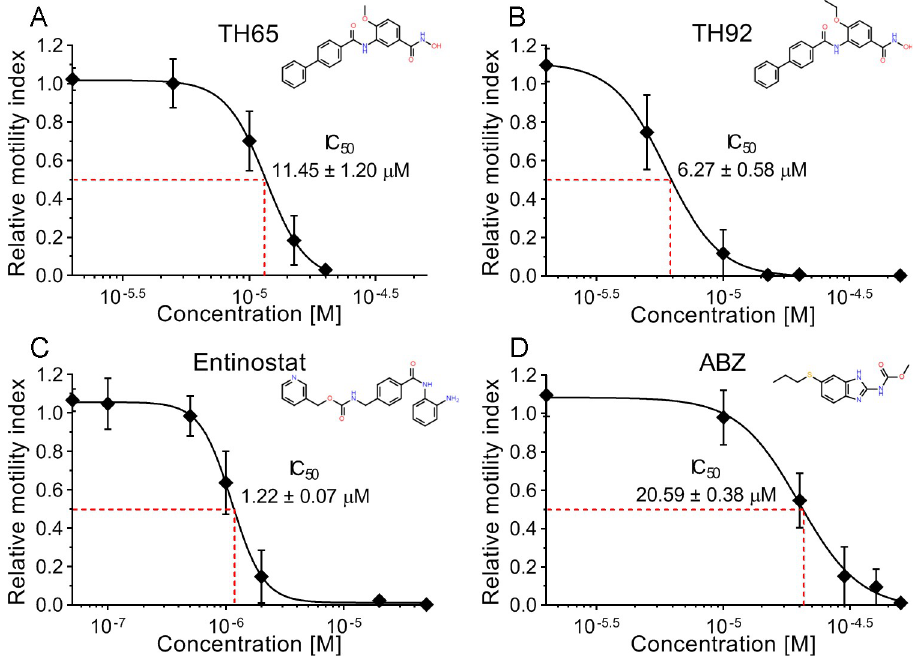
Fig 3. Anthelmintic dose-dependent effect of selected HDAC inhibitors and albendazole (ABZ). The anthelmintic dose-dependent effect was determined for the selected HDAC inhibitors (A) TH65, (B) TH92, and (C) entinostat, and (D) the current anthelmintic drug ABZ at 6 days of incubation from three independent biological replicates, each one in quadruplicate. Error bars represent the standard deviation. In each graph, the compounds’ chemical structure and the half-maximal inhibitory concentration (IC 50 ) are shown. IC 50 is expressed in μ M, with the corresponding standard deviation.